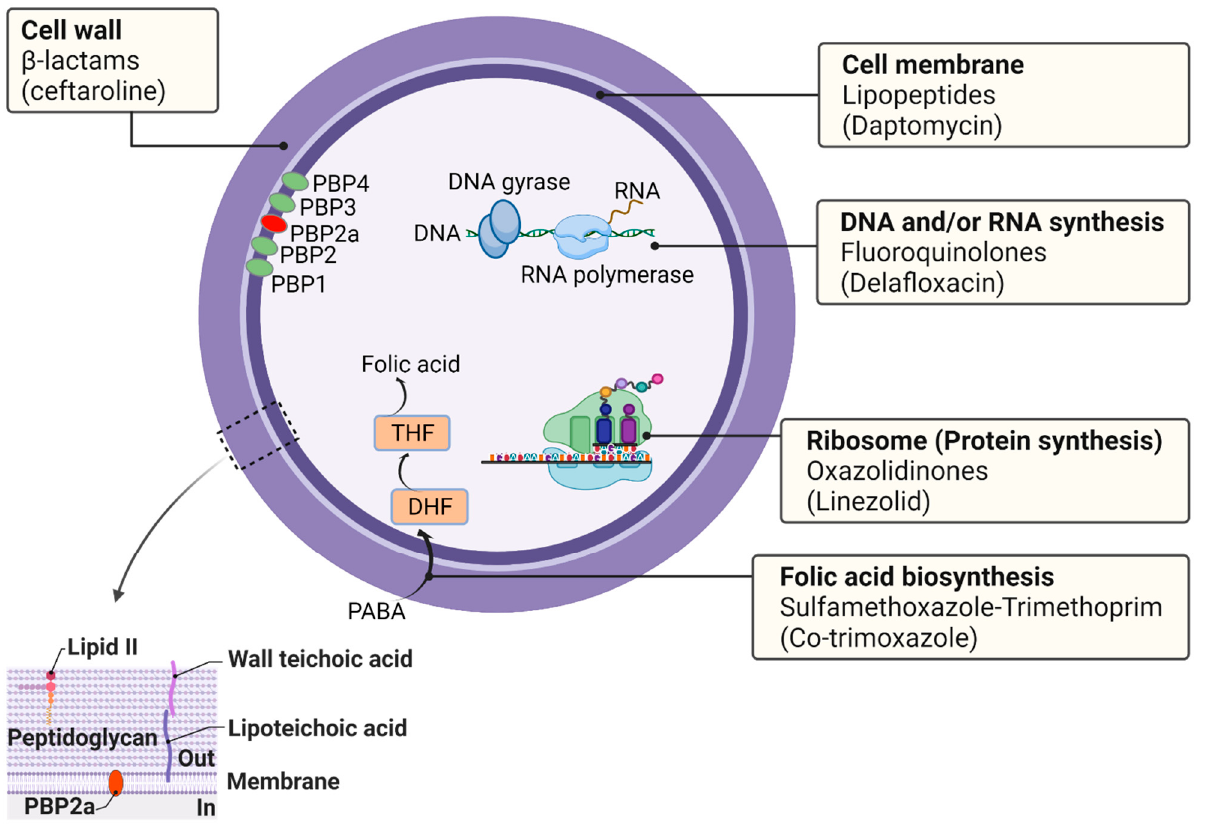
Figure 2. The primary targets of antibiotics in S. aureus . Antibiotics can inhibit the growth of bacteria by targeting their cell wall, cell membrane, DNA replication, RNA synthesis, or ribosomes (protein synthesis), leading to bacterial death. Antibiotics can also inhibit folic acid biosynthesis through a pathway involving para ‐ amino ‐ benzoic acid (PABA), tetrahydrofolate (THF), and dihydrofolate (DHF) as precursors of folic acid.